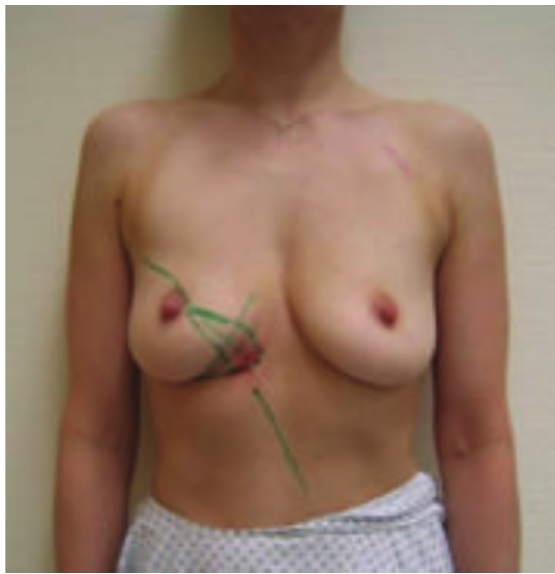
Figure 1: Patient of 43 years, ypT0pN0 resection volume 30 g, cup 75C.